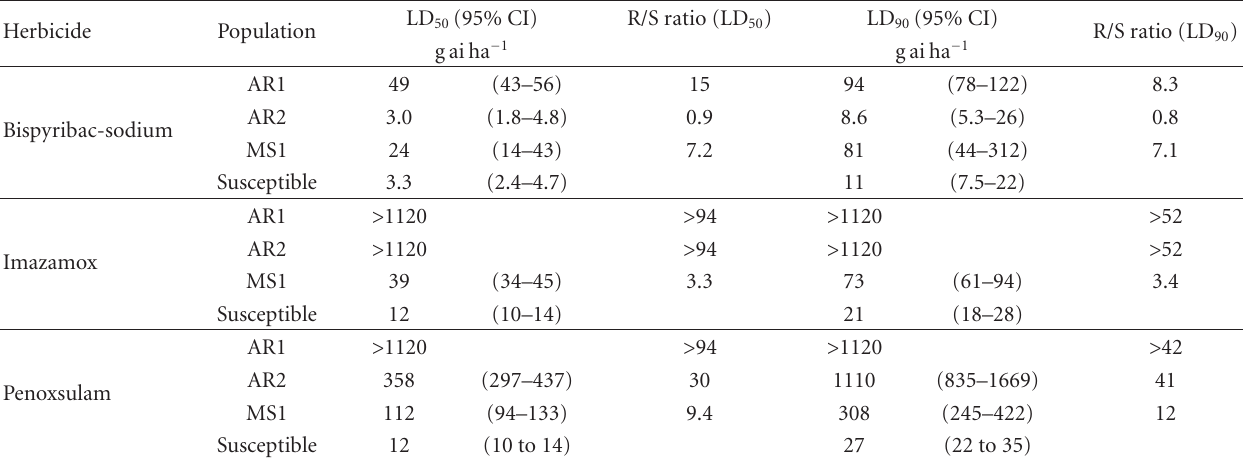
Table 3: Bispyribac-sodium, imazamox, and penoxsulam dose required to kill 50% (LD 50 ) and 90% (LD 90 ) of ALS-resistant (AR1, AR2, and MS1) and -susceptible E. crus-galli populations (with 95% CI in parenthesis) a,b,c,d .